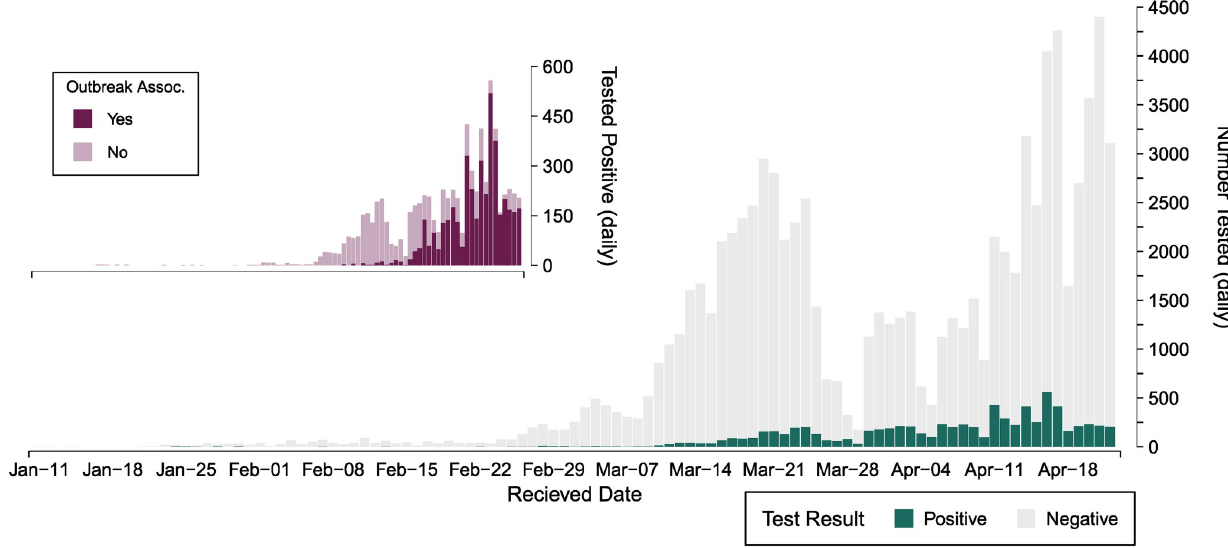
Fig 2. Daily SARS-CoV-2 testing results for specimens received at Public Health Ontario (January 11 –April 22, 2020). Includes inset plot of daily positives coloured by the number of outbreak-associated specimens over the same time period.